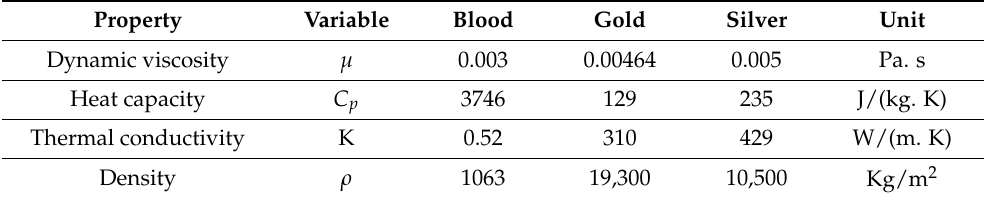
Table 4. The thermophysical properties of the blood base fluid and the silver and gold nanoparticles